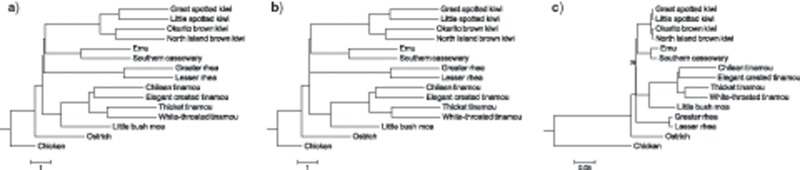
Palaeognath relationships inferred from the total evidence data set of 20,850 loci using MP-EST (a) and ASTRAL (b) species tree methods, and maximum-likelihood analysis of concatenated data with ExaML (c). Bootstrap support values are indicated for clades with \documentclass[12pt]{minimal}
\usepackage{amsmath}
\usepackage{wasysym}
\usepackage{amsfonts}
\usepackage{amssymb}
\usepackage{amsbsy}
\usepackage{upgreek}
\usepackage{mathrsfs}
\setlength{\oddsidemargin}{-69pt}
\begin{document}
}{}$CDATA[$CDATA[$<$$\end{document}100% support. Scale bars indicate branch length in coalescent units for MP-EST and ASTRAL and in substitutions/site for ExaML. Terminal branches in MP-EST and ASTRAL species trees are uninformative and are drawn as a constant value across taxa.